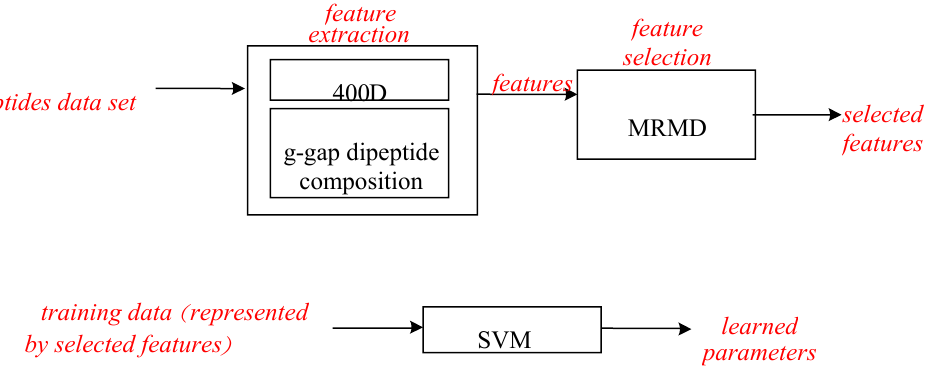
Figure 1. The flow chart of identifying anticancer peptides. MRMD: maximum relevance-maximum distance; SVM: support vector machine.